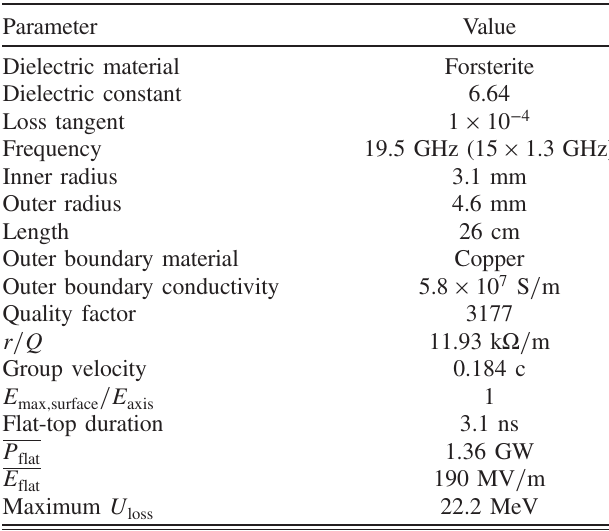
TABLE II. Parameters of the uniform section of a future gigawatt dielectric-loaded power extractor using AWA drive beam